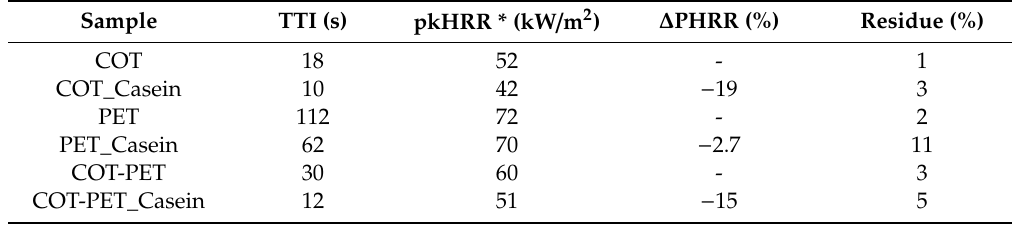
Table 5. Table 5. Cone calorimetry data for untreated and caseins-treated